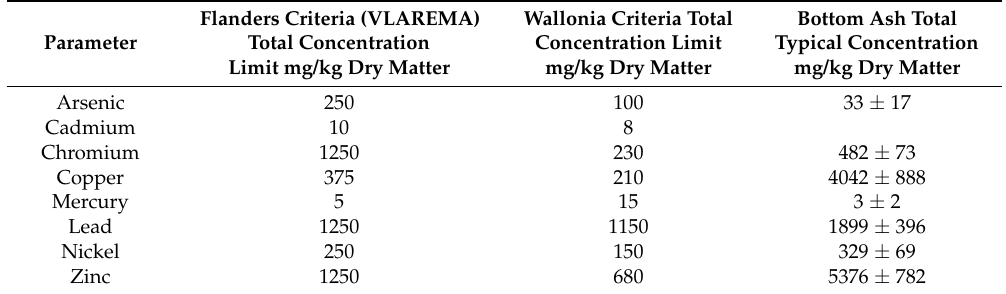
Table 4. Comparison of Flemish and Wallonia guidelines and typical concentrations in bottom ash cf.